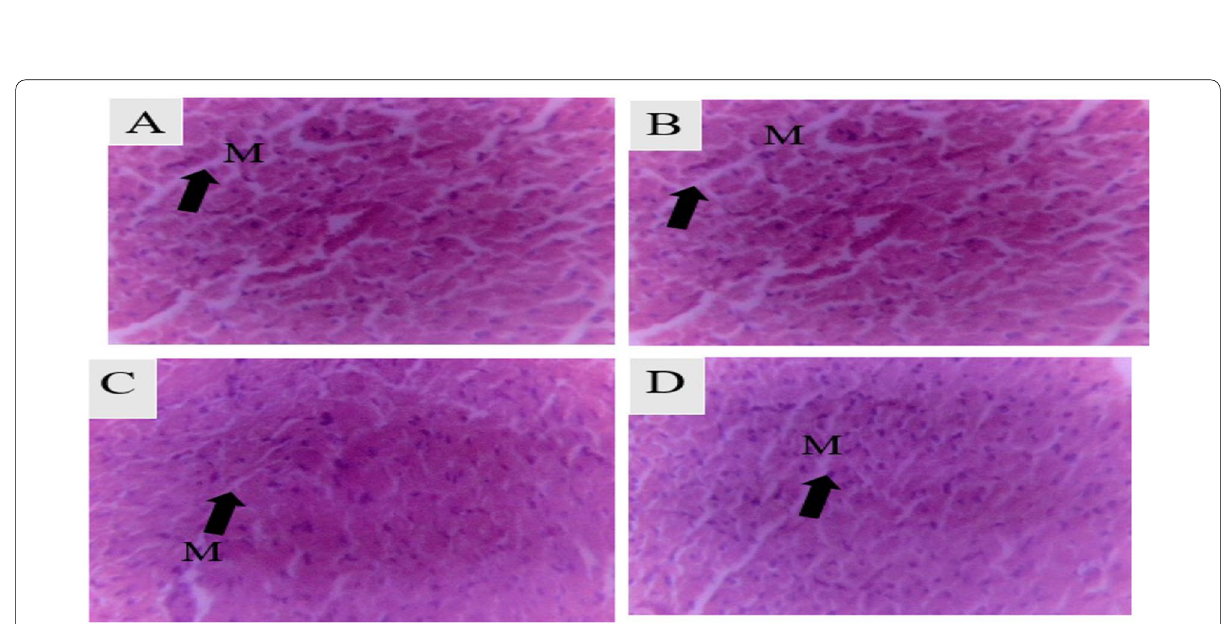
Fig. 4 Photomicrographs of heart sections of rats following 28-day oral administrations of Culcasia angolensis leaves extract (CAE) (haematoxylin and eosin-stained at 250 magnification). A Control (distilled water); B CAE (125 mg/kg); C CAE (250 mg/kg); D CAE (500 mg/kg), M (normal cardiac ×